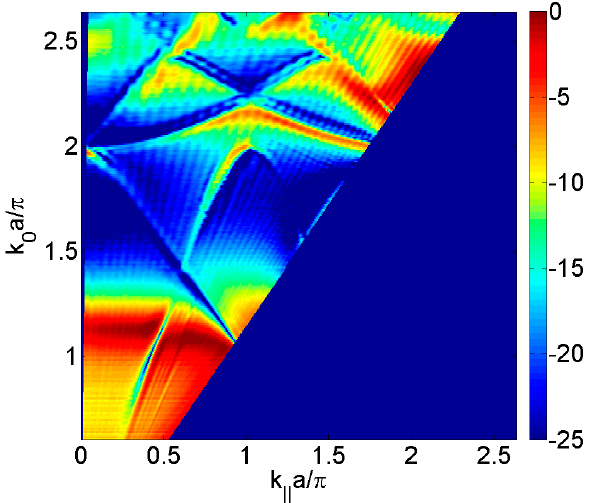
Figure 4. Measured transmitted sound power coefficient, τ , as a function of the parallel wavevector k ‖ · a / π in the Γ X direction and the normalized frequency k 0 · a / π , for the square distribution of circular holes having diameter, d , of 1 mm and a unit cell period, a , of 3 mm. The transmitted sound is represented in dB scale.